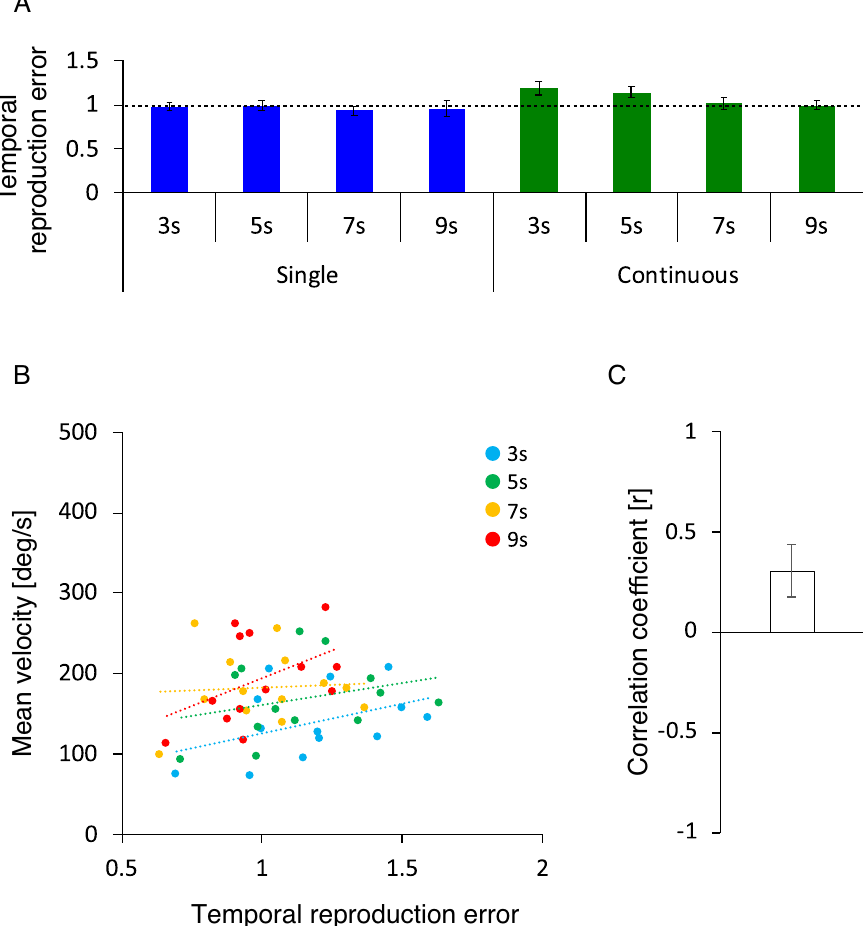
Figure 2. Average temporal reproduction error for the single and continuous action conditions ( A ), regression lines fitted to each duration condition’s temporal reproduction error and steering wheel velocity for the continuous action condition ( B ), and its average correlation coefficient ( C ). Statistical comparisons revealed that, compared with 1 (a dotted line), the temporal reproduction errors in the continuous action condition were higher in the 3-s and 5-s conditions, but identical in the 7-s and 9-s conditions, and the temporal reproduction errors in the single action condition were identical in the all duration conditions ( A ). The slopes of the regression lines appeared to be positive ( B ) and the average correlation coefficient was significantly higher than 0 ( C ). Error bars represent 95% confidence